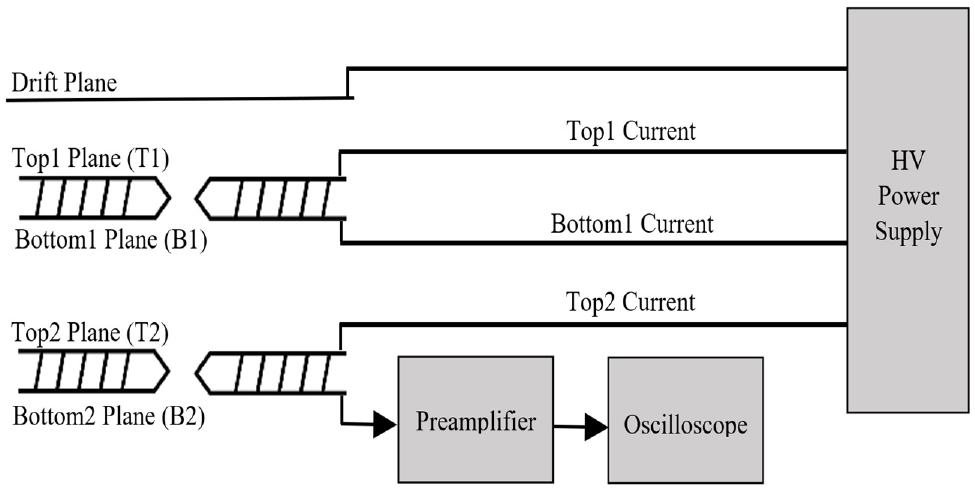
Figure 9. Block diagram of the experimental array to measure the current in the layers of the